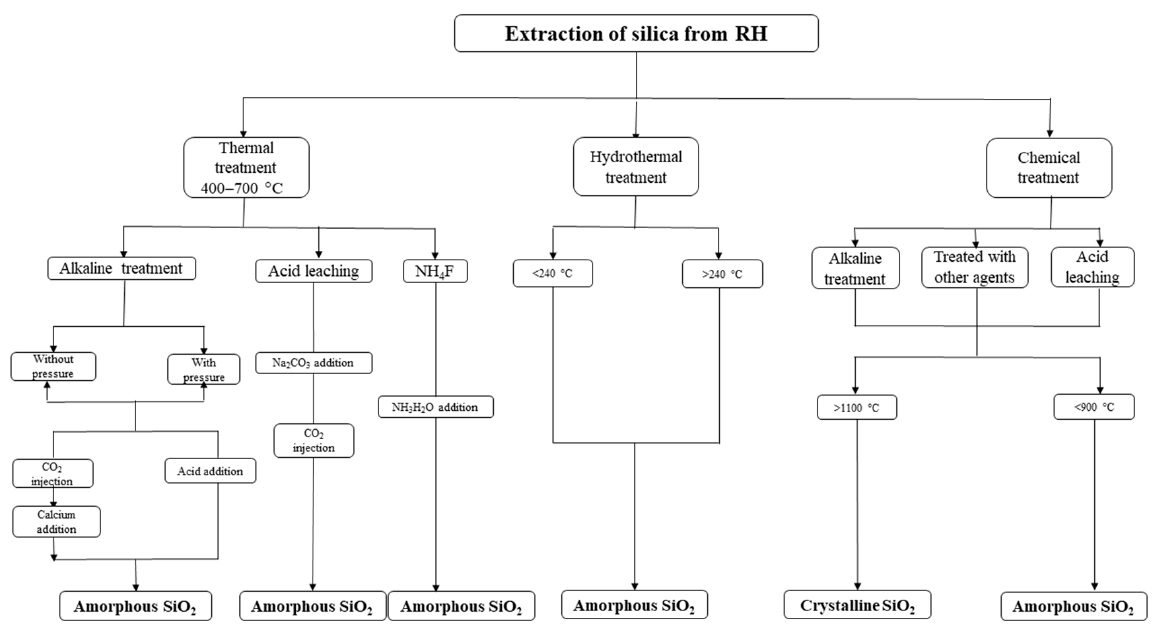
Figure 2. Various processes for silica obtained from RH.